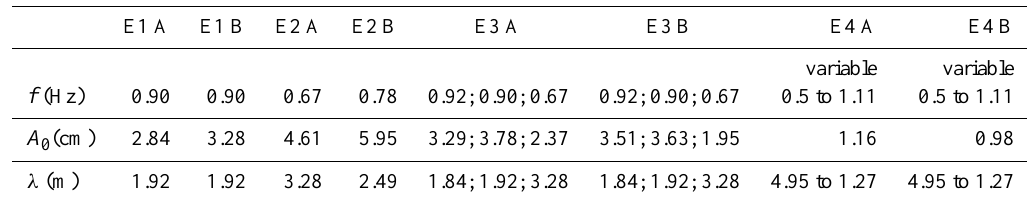
Table 2. Experiment wave properties. f : wave frequencies applied to each tank. A 0 : incoming amplitude measured at sensor group 1 near wave paddle. λ : average wavelength at sensor group